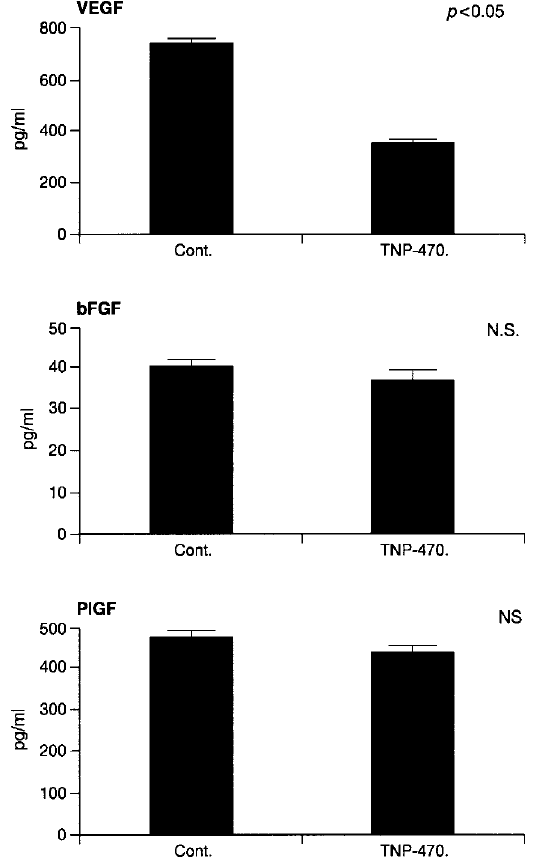
Fig. 5. The effects of TNP-470 on the angiogenic factor pro- duction by HT1080 cells. HT1080 human fibrosarcoma cells (1 3 10 5 ) were cultured for 24 hrs. with or without TNP-470 (10 ng/ml). The concentration of VEGF, bFGF and PlGF which were secreted into the culture media were assayed with enzyme immunoassay kits. Data are means from 3 independent experiments ± SEM.